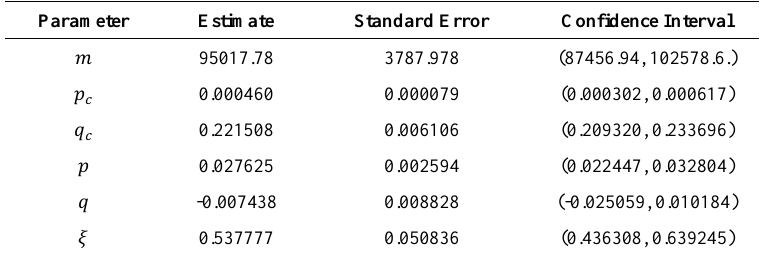
Table 4. Lombardy. Estimates, asymptotic standard errors and 95% mCIs for the parameters of the DMPsw